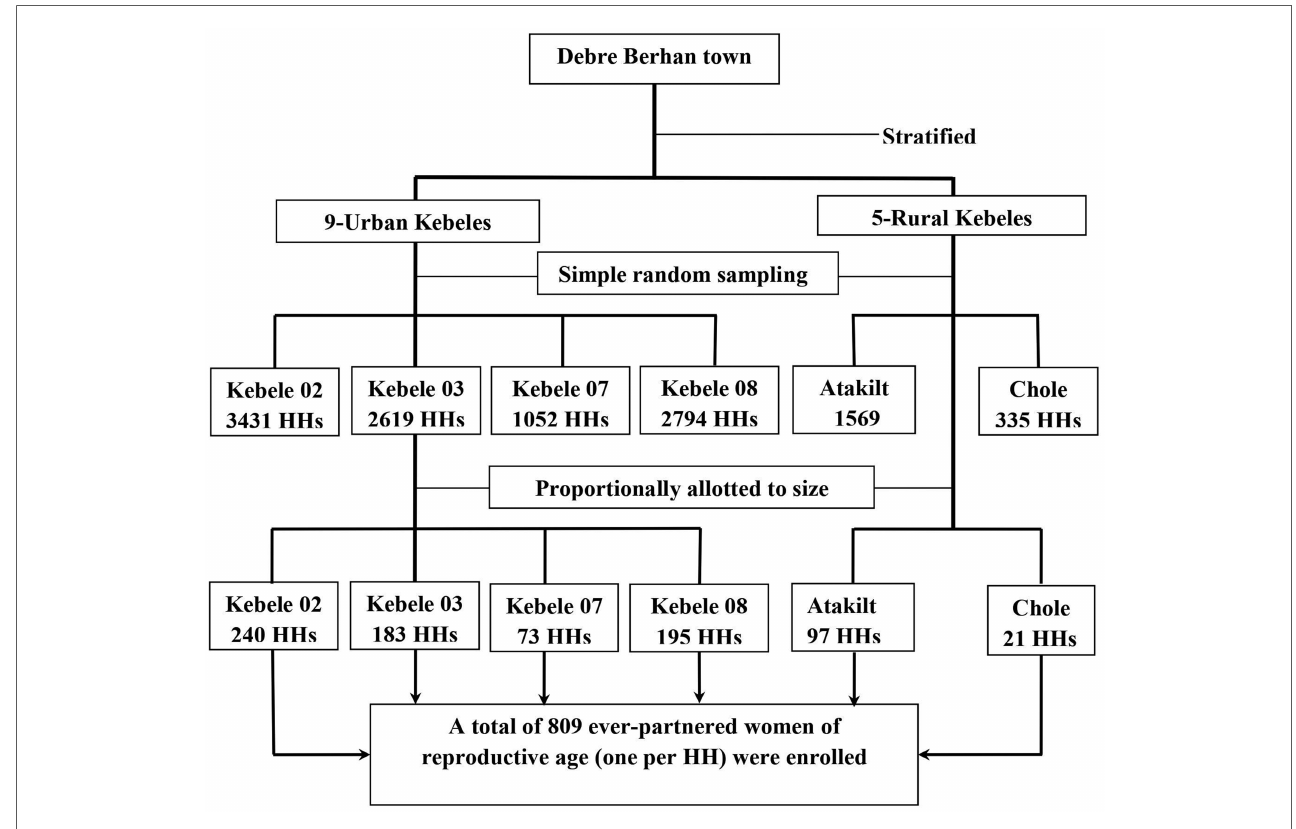
FIGURE 2 Schematic representation of the sampling procedure of ever partnered women of reproductive age in Debre Berhan